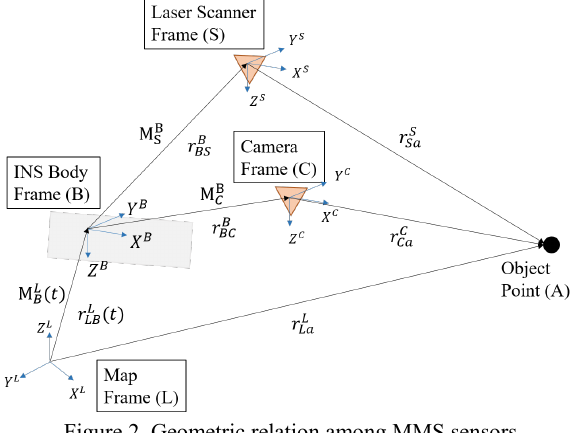
Figure 2. Geometric relation among MMS sensors